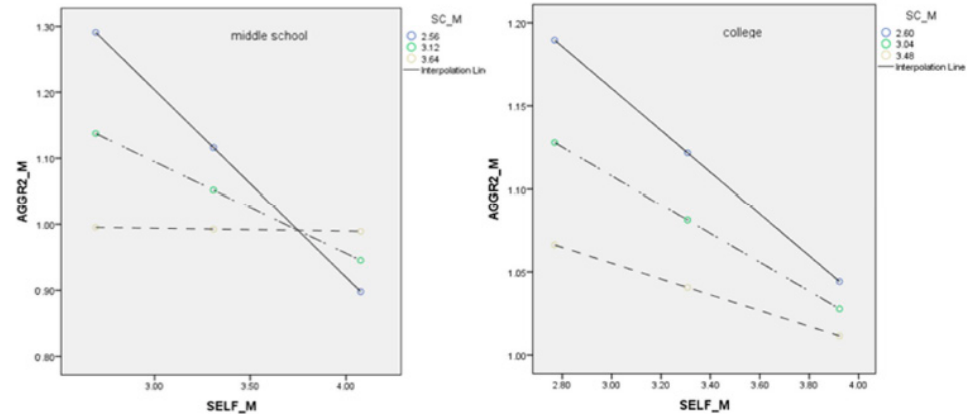
Figure 4. Second half path with school climate being the moderator. Note: SELF = self-control, Figure 4. second half path with school climate being the moderator . Note : SELF = self-control, AGGR2 = reactive cyberaggression, SC = school AGGR2 = reactive cyberaggression, SC = school climate.